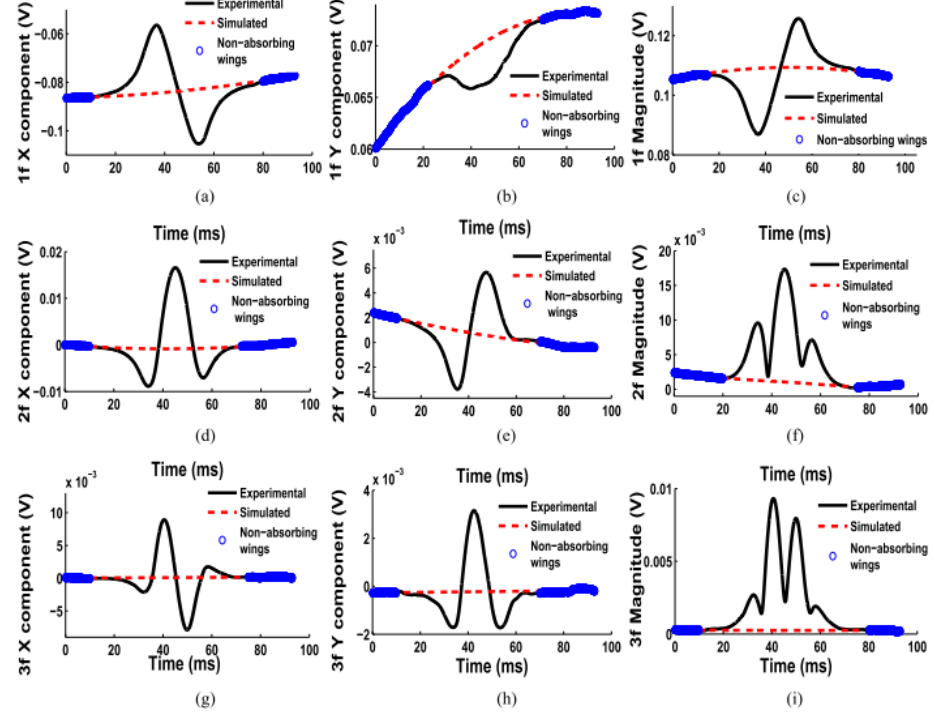
Figure 13. The 1650 nm DFB laser was modulated at m = 2.2, and the transmitted light through a 1% CH 4 sample at 1 bar pressure was demodulated by a lock-in amplifier (LIA) to obtain ( a ) 1 f X-component along I H 1 , ( b ) 1 f Y-component orthogonal to I H 1 , ( c ) magnitude of 1 f Signal, ( d ) 2f X-component along I H 2 , ( e ) 2 f Y-component orthogonal to I H 2 , ( f ) magnitude of 2 f Signal, ( g ) 3 f X-component along I H 3 , ( h ) 3 f Y-component orthogonal to I H 3 , and ( i ) magnitude of 3 f Signal. Figure adapted from [104].